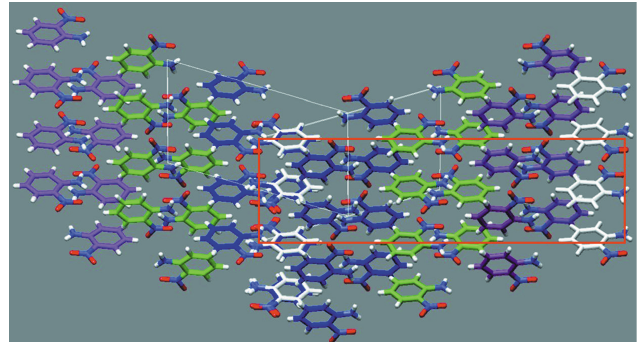
Figure 4 Left: simulated precession photograph in the h 0 l plane of (I) up to a resolution of 0.9 (A˚ ). The reconstruction is based on seven scans with a total of 3324 raw images. Right: zoomed image, is from the yellow square in the left image. White circles are the predicted impacts for the first twin component, blue circles for the